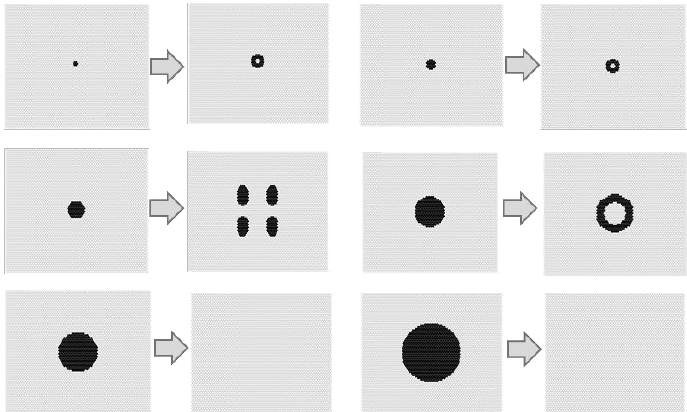
Figure 14. Calculation results, when increasing the black region as the initial condition, under the same conditions as in Figure 12 ( s = 4, t = 8, w 1 = 0.40, and w 2 = 0.75 in a hexagonal grid). The point symmetrical initial shape tended to be a fixed pattern, due to the balance of each of the rules. On the other hand, if the black area is larger than a certain size, Rule 1 is mostly applied, and disappeared at the second step. To produce a self-replicating pattern, an asymmetric shape must initially occur.